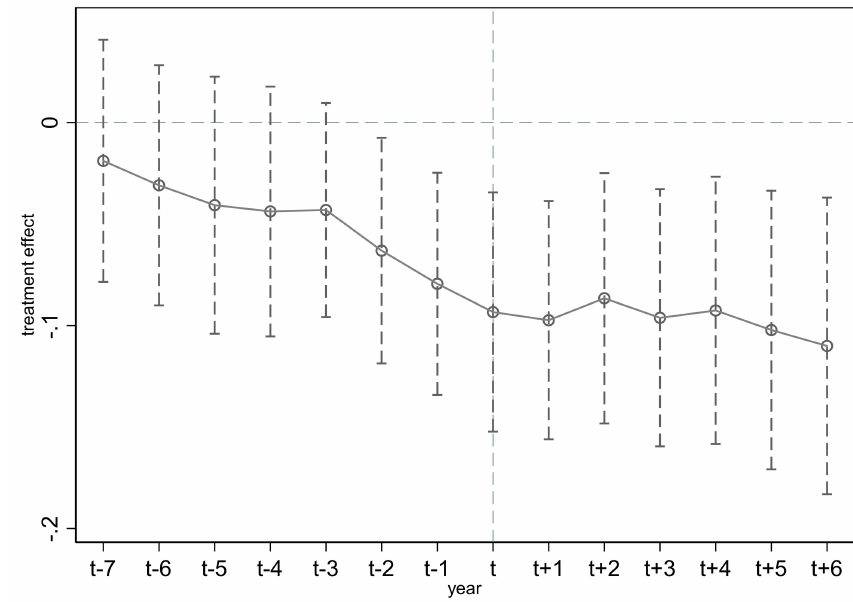
Figure 2. The dynamic effect of the carbon trading pilot policy on carbon